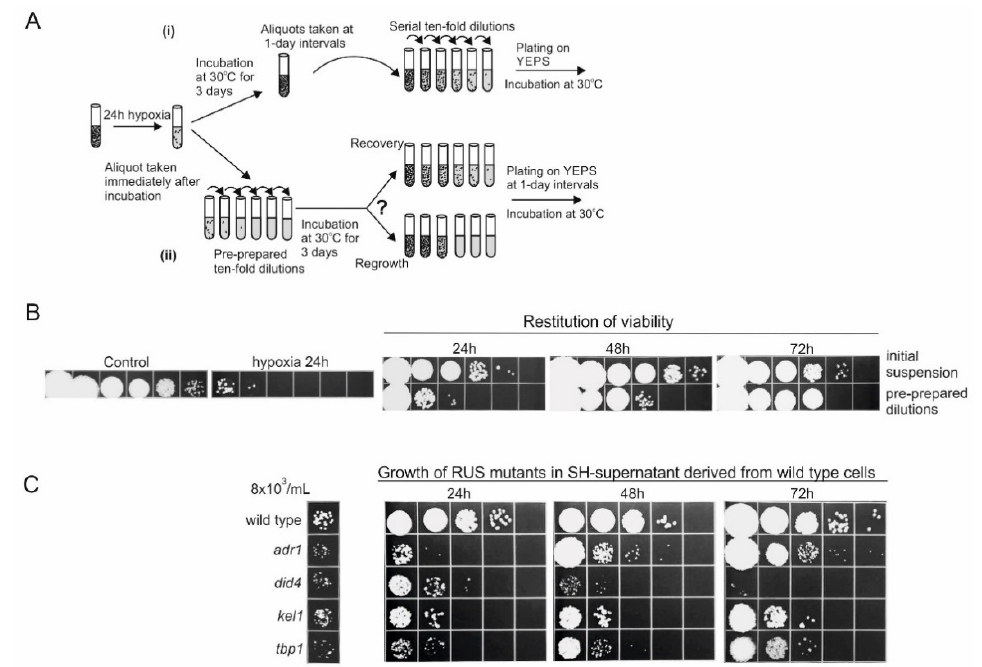
Figure 4. Restitution of viability under aeration of cells that died during incubation in water, in 1.5 mL tubes (24 h hypoxia). ( A ) Schematic diagram of the experimental design. The increase of cell viability was monitored at 1-day intervals in (i) the original suspensions of the cells incubated in water at 30 ◦ C, under continuous agitation, before preparation of serial dilution and plating, or in (ii) pre-prepared 10-fold serial dilutions, following incubation under the same conditions. ( B ) Initial wild-type cell suspension (died upon 24 h-incubation under limited aeration) and its serial dilutions (pre-prepared dilutions) were incubated in water in 50-mL tubes under aeration, at 30 ◦ C for 3 days, and spotted on the solid growth medium in one-day intervals. ( C ) Comparison of restitution of viability under aeration of wild-type and RUS mutants in supernatants derived from 24-h-incubated high cell density suspension of wt cells, under limited aeration (SH-supernatant). Wild-type cells (4 × 10 8 /mL) were incubated in water in 1.5 mL tubes (hypoxic conditions). After 24 h, cell suspensions were centrifuged and Millipore filtrated supernatants were inoculated with 8 × 10 3 wild-type cells or RUS mutants, and incubated for the next 72 h under aeration (50 mL tubes). At one day intervals, aliquots were withdrawn, 10-fold serial dilutions were prepared and spotted on the solid medium. The panels are representatives of three independent